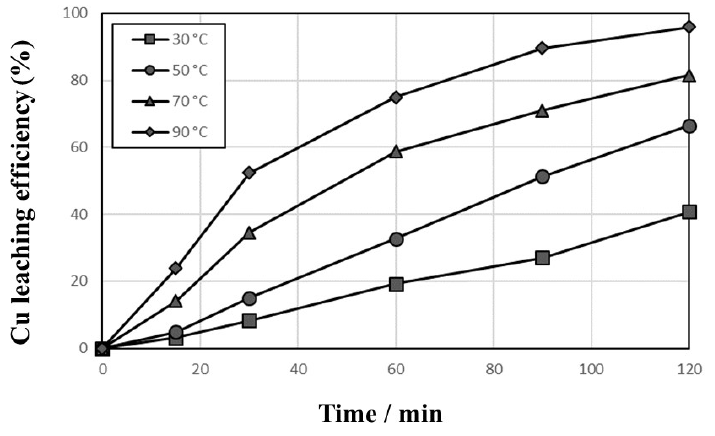
Figure 4. Effects of temperature on the leaching behaviors of Cu in 1 mol/L sulfuric acid solution at 600 rpm with 10,000 mg/L Cu 2+ , 1% pulp density, and 1000 cc/min O 2 introduction.